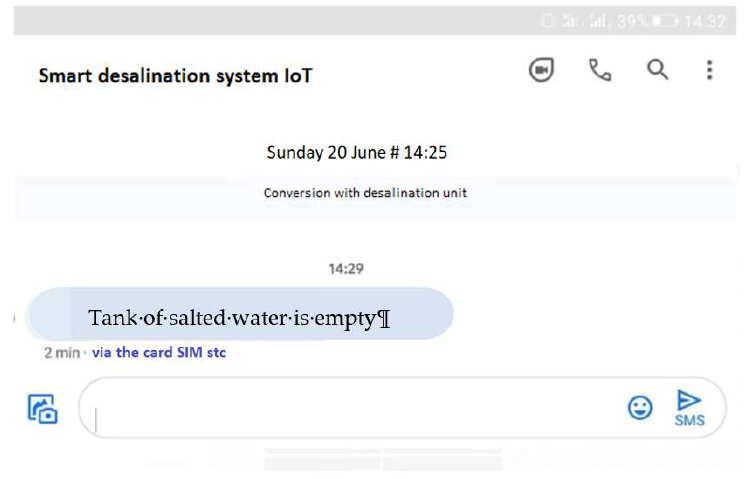
Figure 10. SMS notification (e.g., tank of salted water is empty).